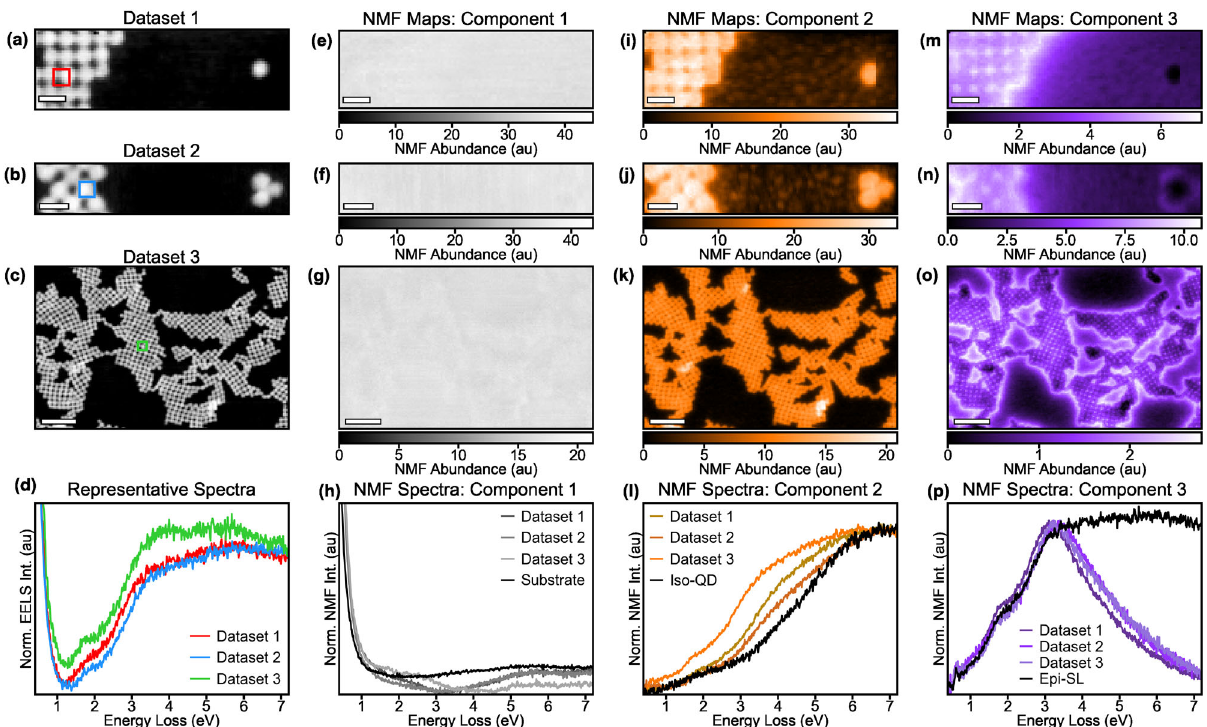
Fig.4|Realizationofbandgapmodulationinepi-SLswithNMFanalysis. Three EEL SIs of QDs with no necks compared to the epi-SLs with necking. a – c HAADF STEMreferenceimagesofthethreedatasets. a Showsthedatasetwithonlyasingle iso-QD located near the epi-SL from the Fig. 3. b Shows a trimer cluster without necking, ( c ) shows a large area epi-SL containing various necking con fi gurations. d The representative spectra from the marked regions in a , b , and c showing that the electronic structures of the three epi-SLs is nearly identical. NMF